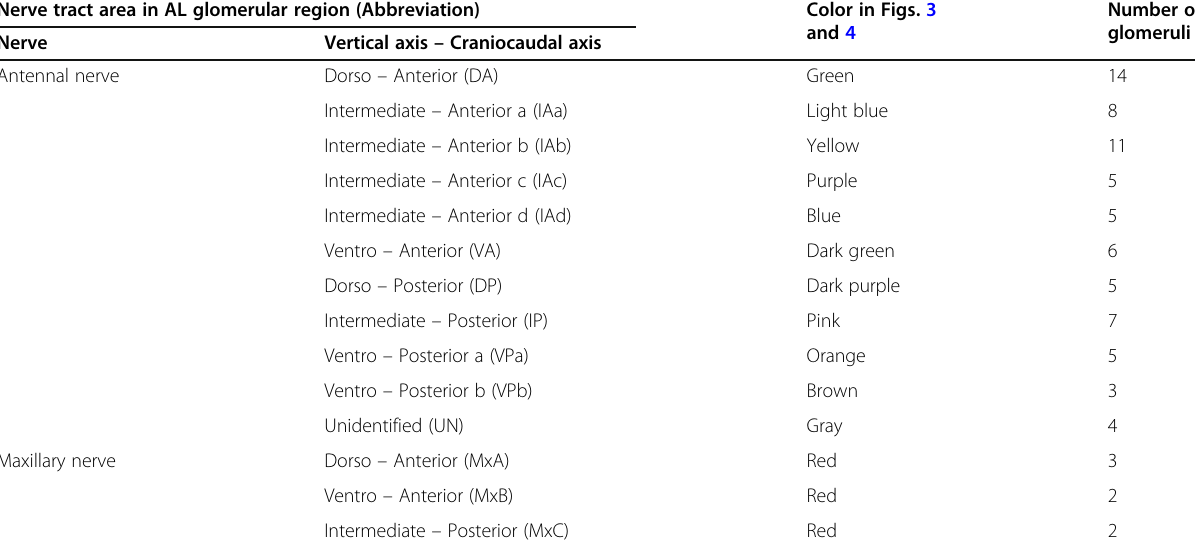
Table 1 Subdivision of 80 glomeruli of P.